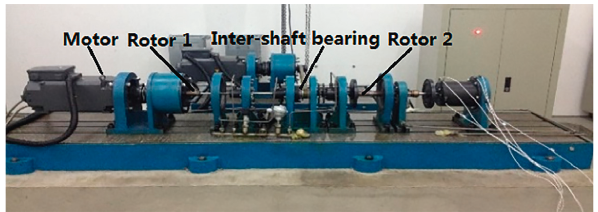
Figure 1: Rotor simulation test rig for intershaft bearing faults.